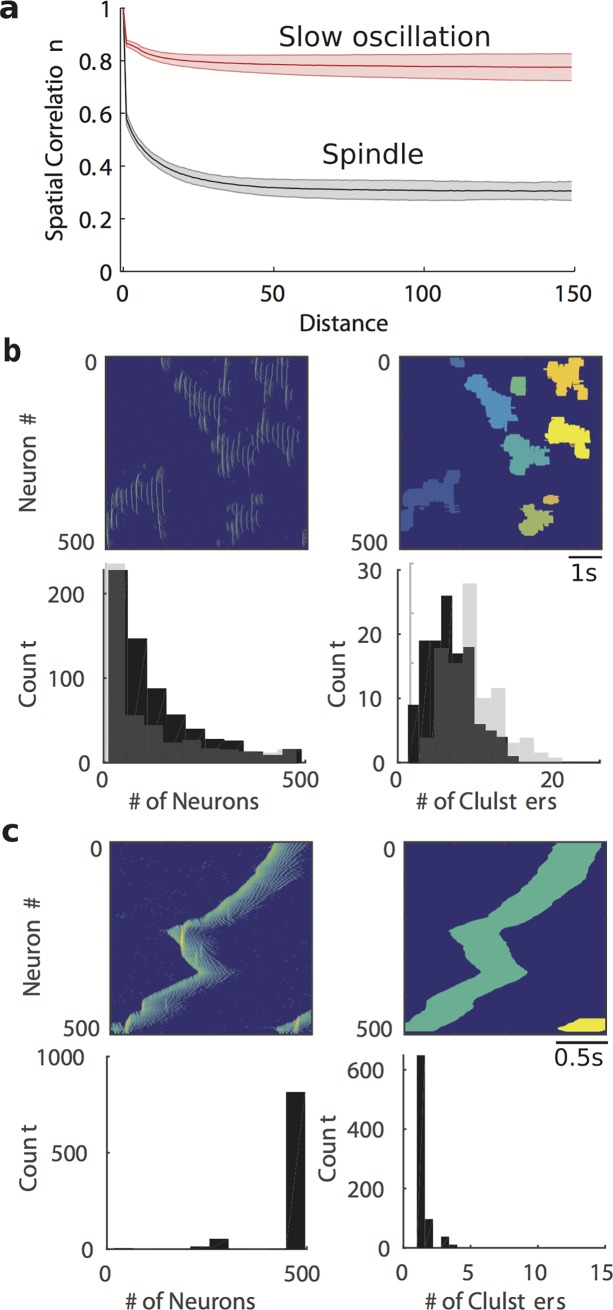
The differential spatiotemporal pattern of sleep spindles and slow oscillations.a) Spatial correlation between neurons at the different distance during sleep spindles and slow oscillations. The patch error bar represents standard deviation. b,c) An example of smoothed spike trains (top left) and the clustered region (top right), the histogram of neuron number (bottom left) that were identified within a cluster and the histogram of cluster numbers (bottom right) during spindle (b) and slow oscillations (c). The grey bar in b) is the histogram of temporally-cooccurring clusters that are monosynaptic connected during spindles.